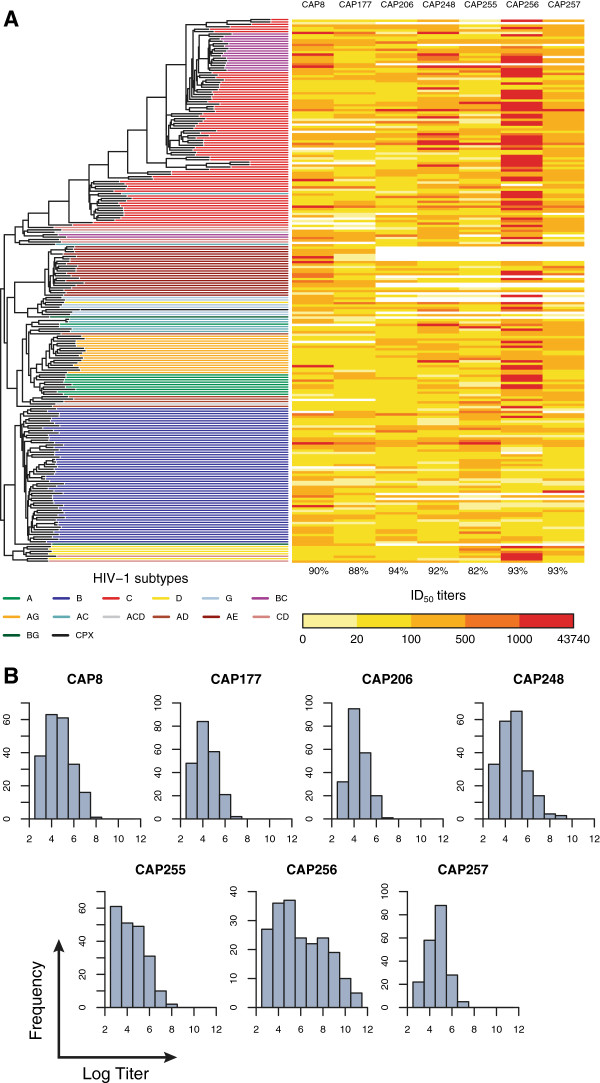
ID50 titers for each serum sample. (A) Heat map of ID50 titers clustered by the viral phylogeny. The percentages below the heat map indicate the percentage of panel viruses that were neutralized (ID50 > 20) by the antibodies in each serum. (B) Histograms of the natural logarithm of ID50 titer. The distribution for CAP256 was notably different from that of the other sera.